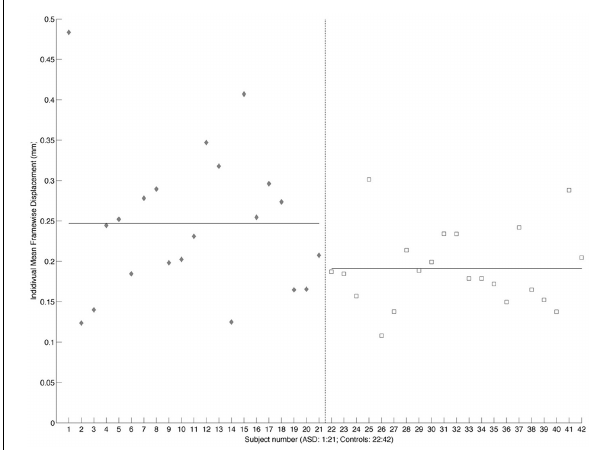
FIGURE 1 | Scatterplot showing individual mean framewise displacement. Individual subjects are shown on the x -axis and framewise displacement (mm) on the y -axis. ASD subjects are shown as gray diamonds and controls as white squares. The dashed vertical line divides the two groups. Solid horizontal lines across the ASD and Control values show the group